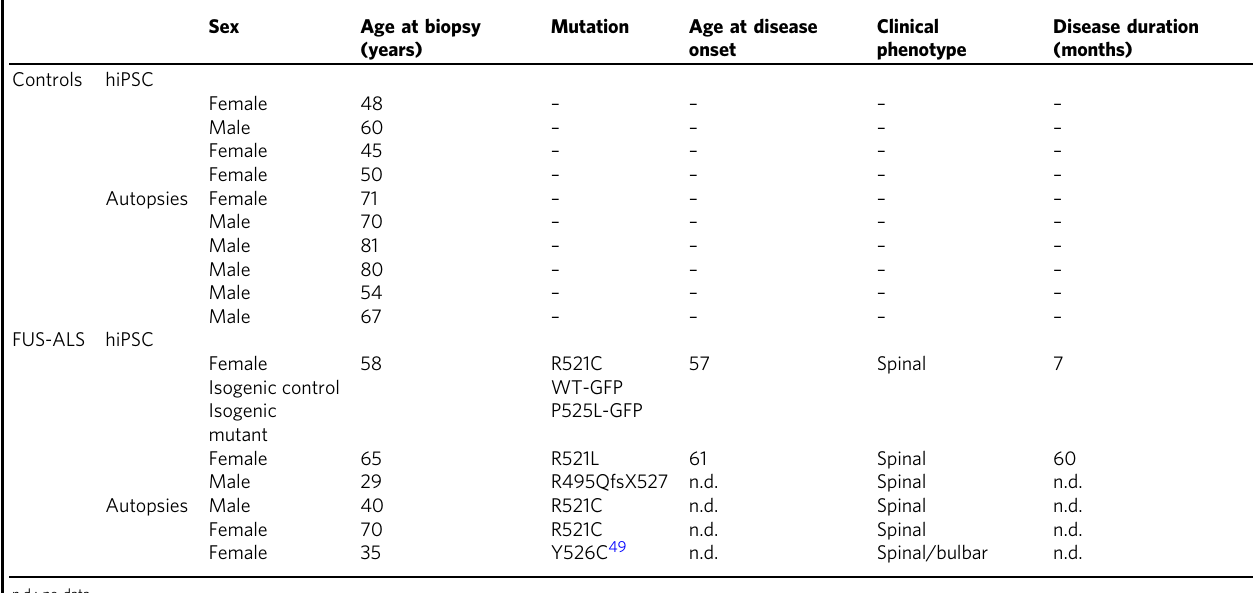
Table 1 Patient/proband characteristics